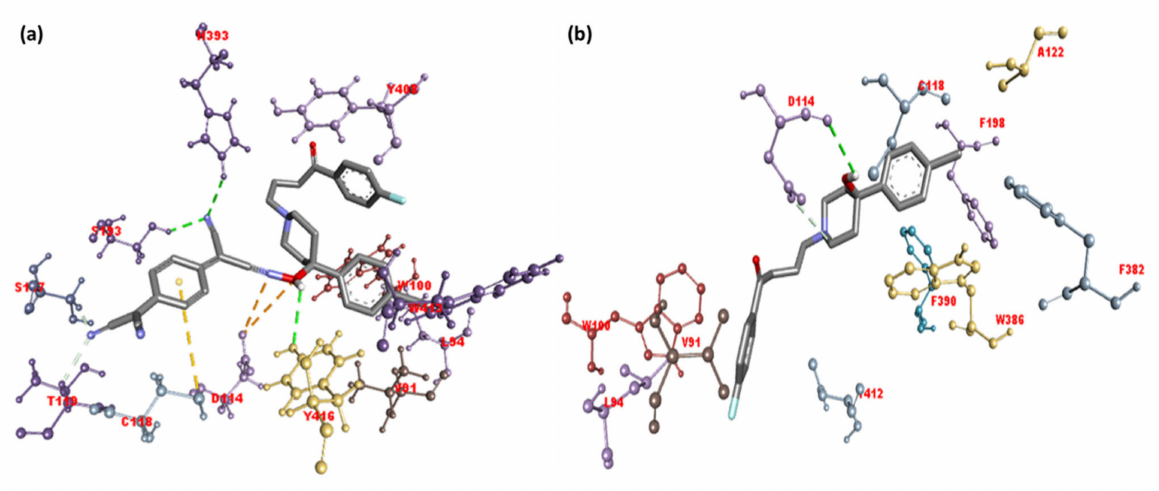
Figure 5. 3D representation of the interactions for dopamine docked with ( a ) CT complex and ( b ) HPL drug only.